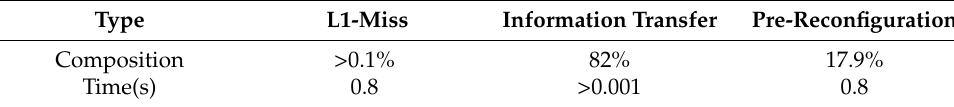
Figure 1. Overall structure of mIoT platform. Table 1. Type of communication between edge and